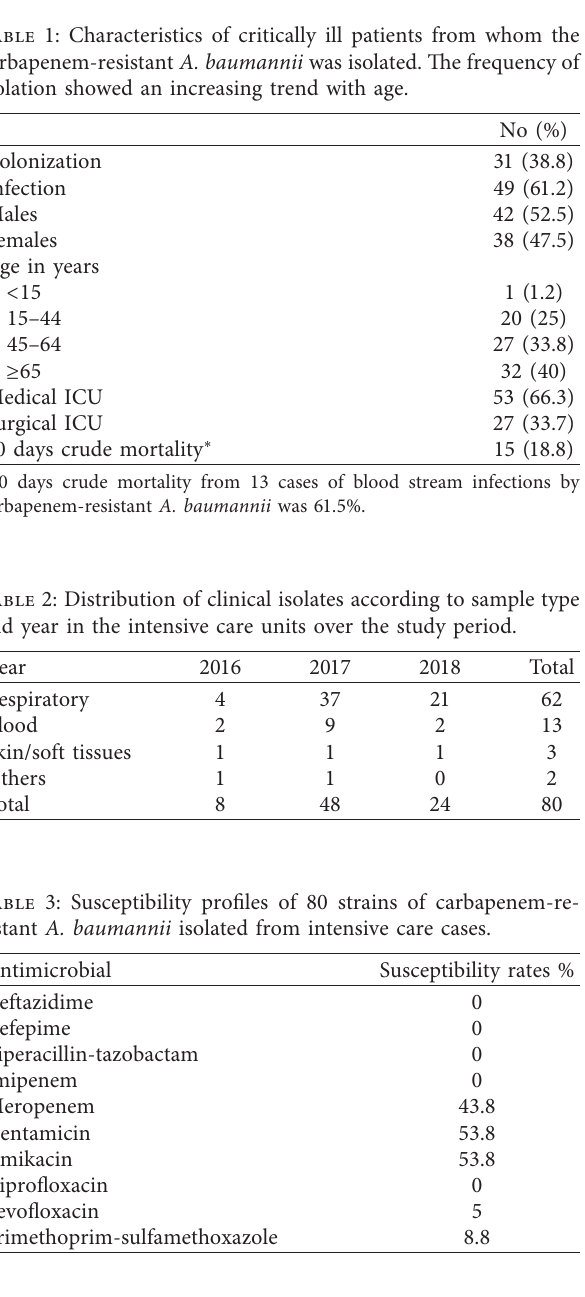
Table 5: Minimal inhibitory concentrations of tigecycline